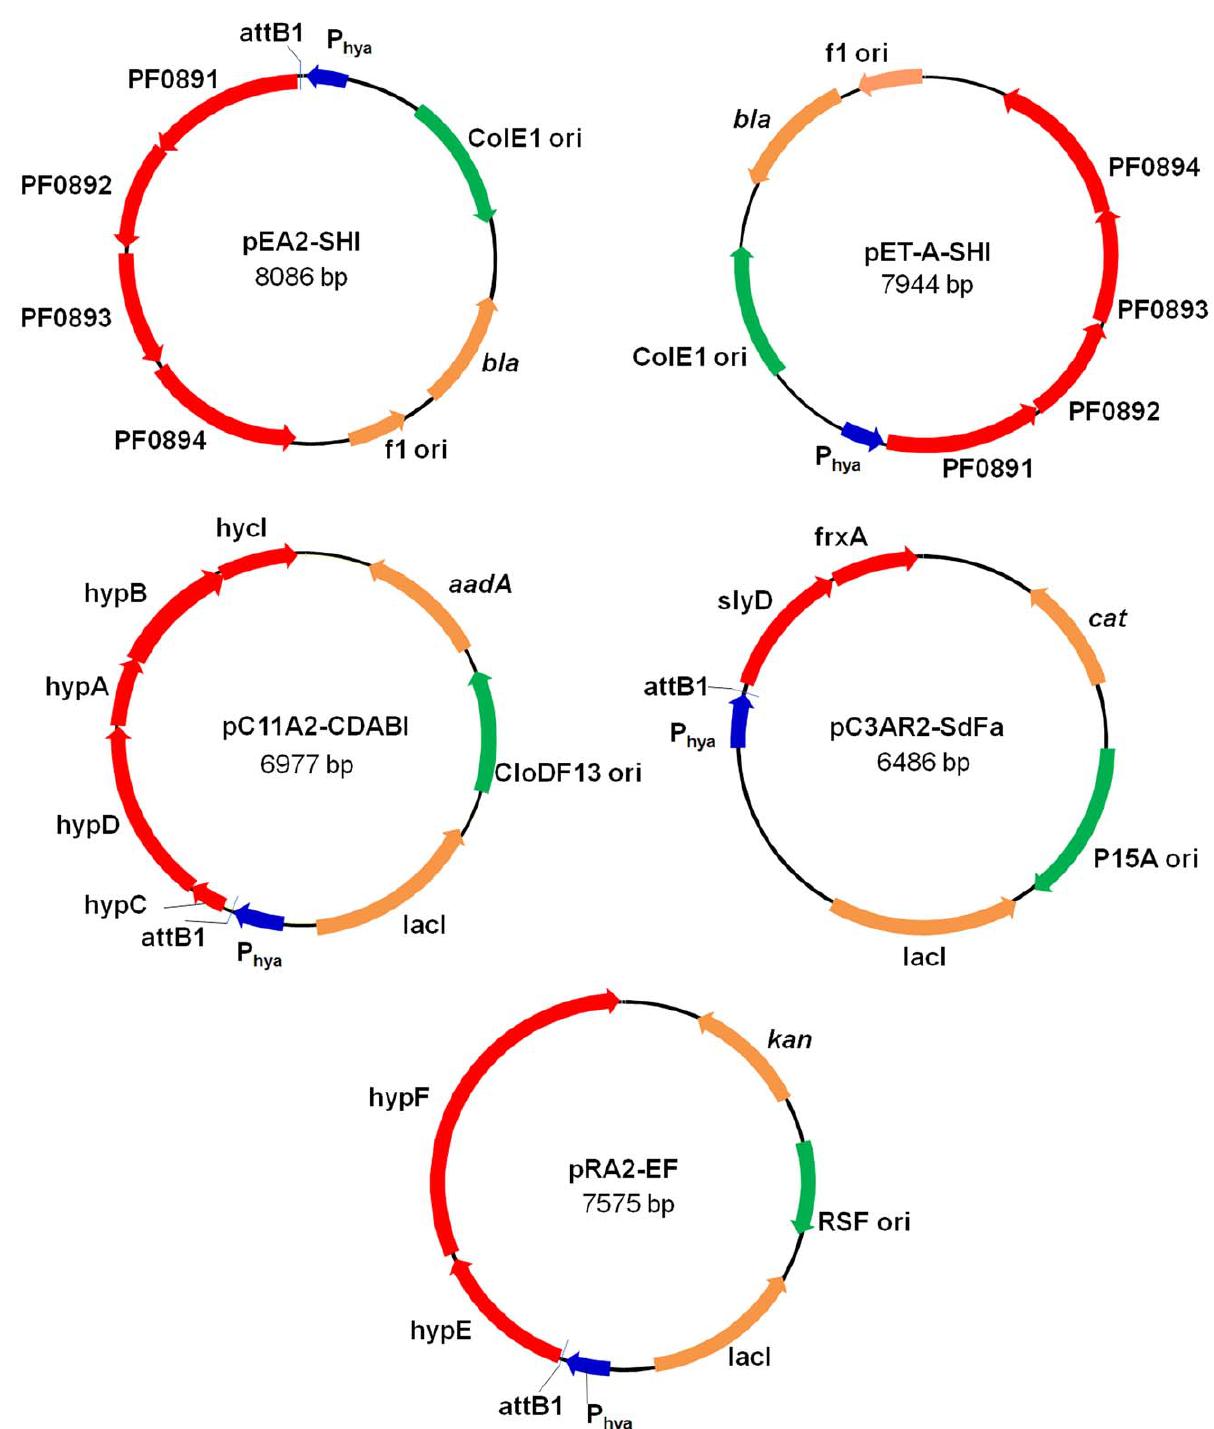
Figure 7. Maps of expression plasmids. Plasmid pEA2-SHI and pET-A-SHI were used to express rSHI in E. coli , and pET-A-SHI was used to generate SHI with a Gateway sequence and TEV recognition site attached to the N-terminal of PF0891 subunit. The plasmid pC11A2-CDABI contains the operons hypCD and hypAB, hycI from P. furiosus . The operons hypCD and hypAB, hycI of P. furiosus were linked by an intergenic region shown in Figure 3c. The Gateway sequence is located at the N-terminus of the HypC protein. The plasmid pC3AR2-SdFa has slyD and frxA of P. furiosus cloned behind P hya , the recombinant SlyD has the N-terminal Gateway sequence/TEV site. Plasmid pRA2-EF was constructed to co-express HypE/HypF, the same linker as in the plasmid pC11A2-CDABI or pC3AR2-SdFa, is inserted between hypE and hypF gene, and HypE contains the N-terminal Gateway sequence.